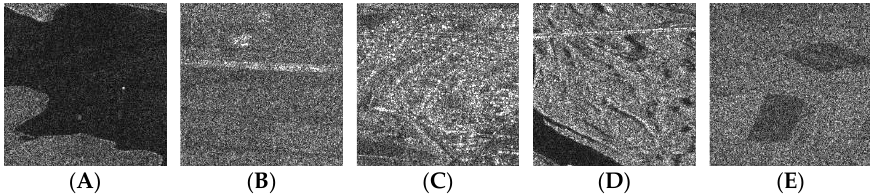
Figure 9. Categories of objects visually distinguished at the Constanța scene level: ( A ) water, ( B ) roads, ( C ) built-up area, ( D ) forest, and ( E ) agricultural fields.